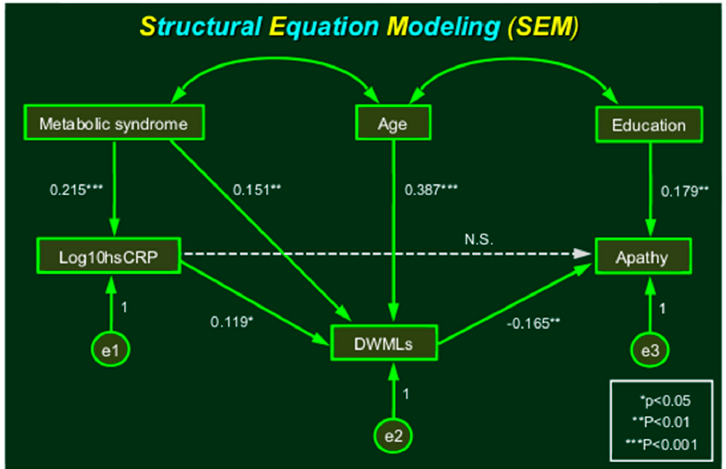
Figure 1. Structural equation modeling (SEM) shows that apathy was indirectly associated with inflammation (log 10 hsCRP) through deep white matter lesions (DWMLs).